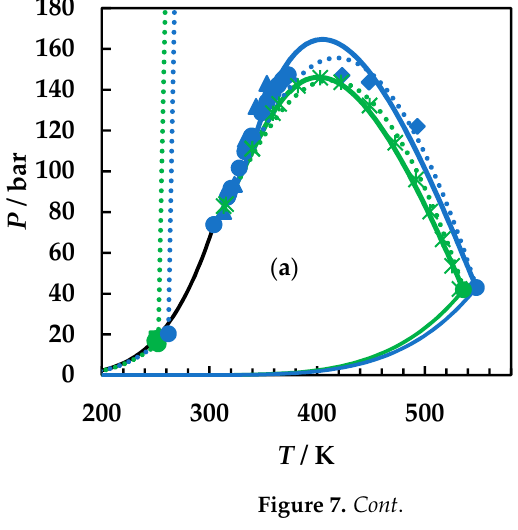
Table 8. GEOS parameters ( α c , m ) for pure components. Figure 7. Cont